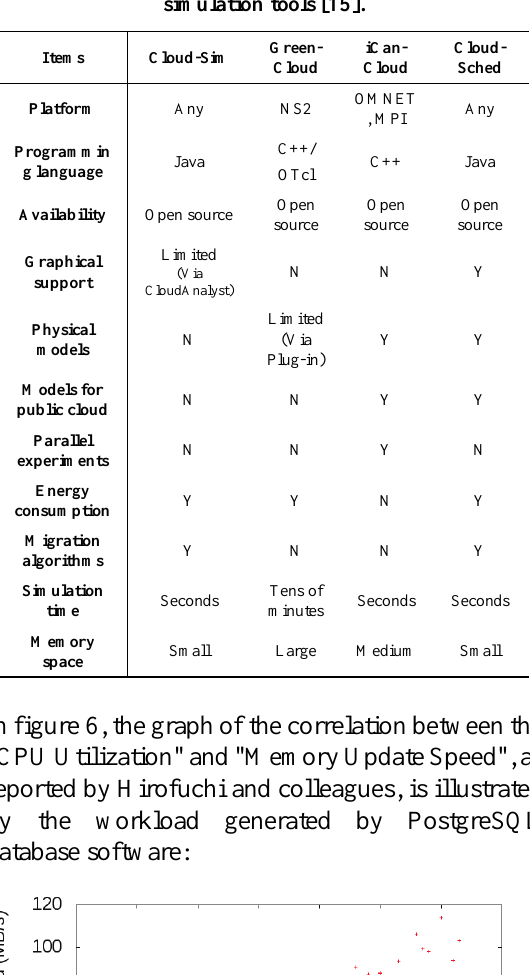
Table 3. Comparison of the characteristics of the four simulation tools [15].